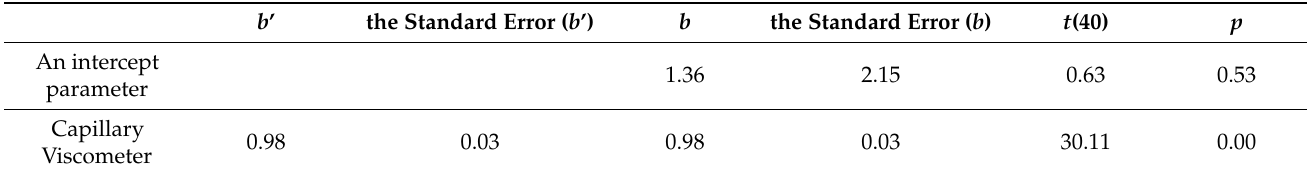
Table 4. The estimation results for the measurements carried out with a Stabinger viscometer and Capillary viscometer. b ’